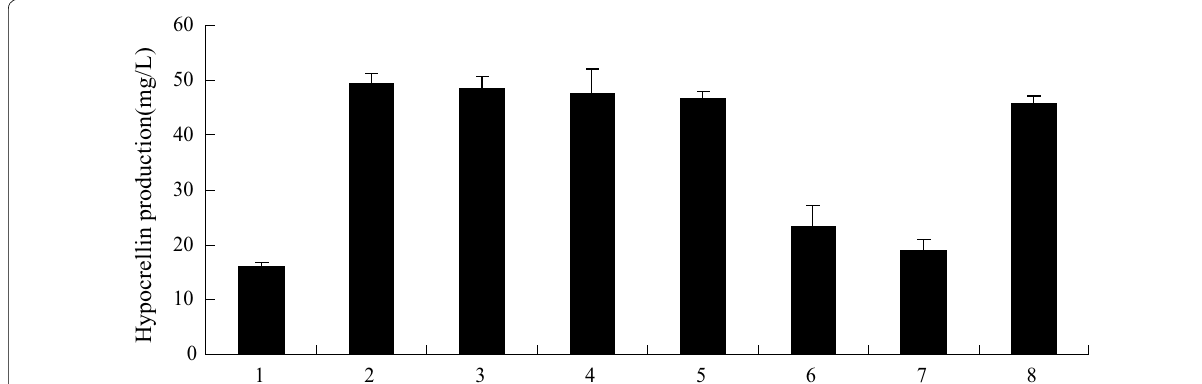
Fig. 4 Effects of different quenchers on PB90-triggered hypocrellin production. Three-day-old cells treated with 10 mmol/L glycerol, 10 mmol/L histidine, 200 units/mL SOD, 200 units/mL CAT, 0.5 mmol/L cPITO, 150 mg/L verapamil and 5 nmol/L PB90, hypocrellin production were measured at 3 days after PB90 was added. The quenchers were added 30 min before PB90 treatment. The control received vehicle solvent only. Values were means of five independent experiments. Bars represented standard errors. (1) Control; (2) PB90; (3) PB90 PB90 SOD; (6) PB90 CAT; (7) PB90 cPITO; (8) PB90 verapamil + + + +